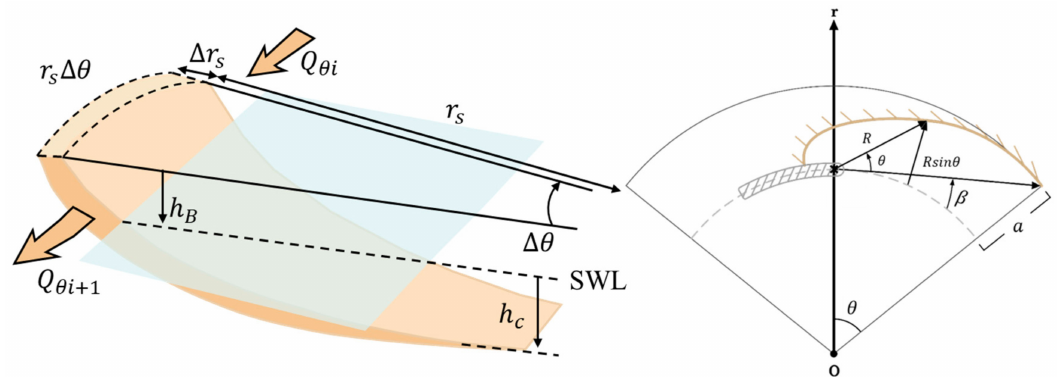
Figure 4. Concept diagram for shoreline change model as applied to polar coordinate